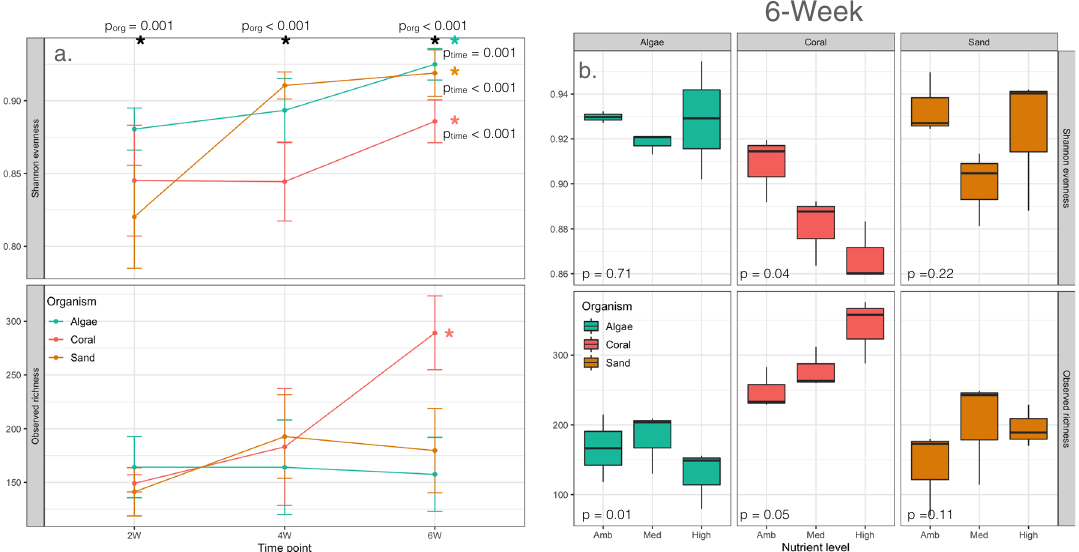
Fig. 4 Changes in alpha diversity metrics of bacteria richness and evenness in bio fi lms through time in response to benthic organism and nutrient treatments. a Richness and evenness signi fi cantly increased over 6 weeks ( p time < 0.001) independent of the benthic organism with which they were cultured ( p org < 0.001). Black asterisks indicate time points with signi fi cant organismal effect ( p org ≤ 0.001). Color coded asterisks indicate an increase in richness or evenness between 2 and 6 weeks ( p time ≤ 0.001; green = algae, pink = coral, yellow = sand). b Within each organismal treatment, nutrients differentially impact bio fi lms at 6 weeks and had opposing effects on richness and evenness in coral treatments.